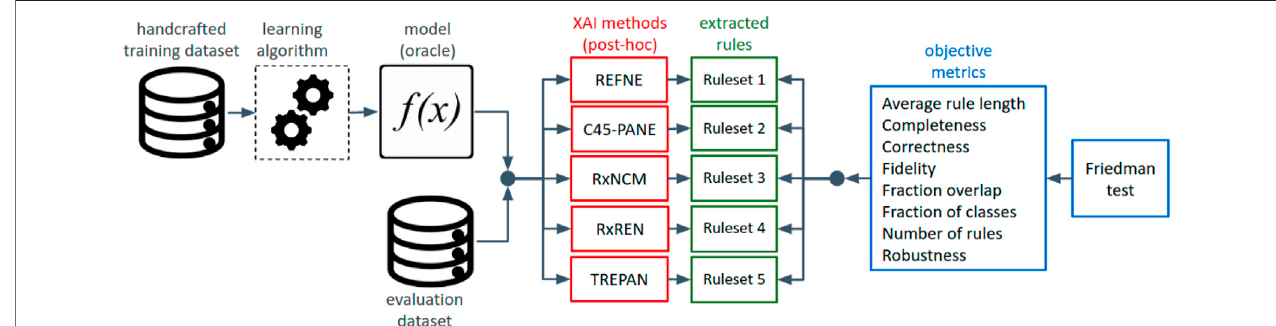
FIGURE 2 | Diagrammatic view of the design of the experiment for evaluating and comparing the explainability of rule-sets, automatically extracted from neural networks by different methods for